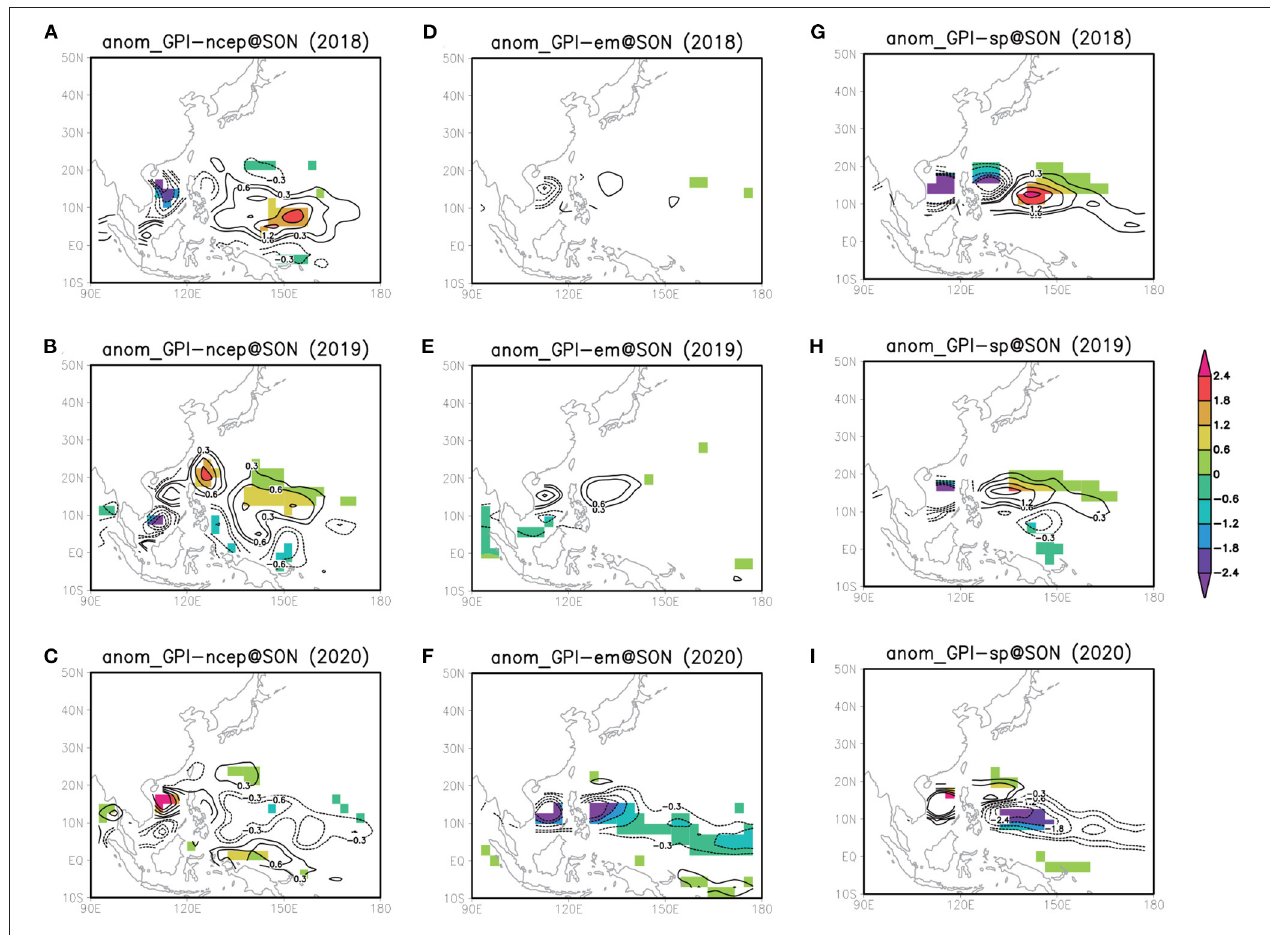
FIGURE 3 | Same as Figure 2 , except for the GPI anomaly during boreal fall